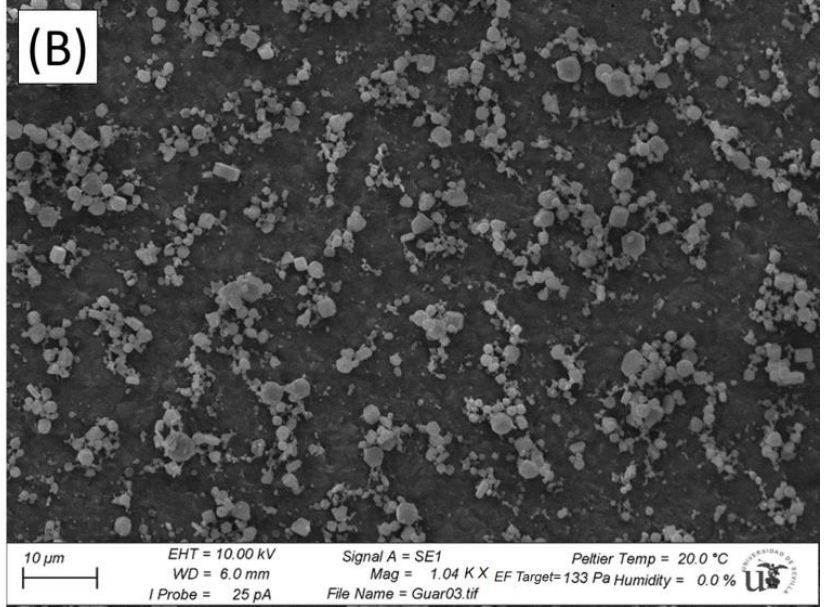
Figure 6. ( A ) Microstructure formed by linseed oil emulsion formulated with 0.3 wt.% of APXG observed by SEM. ( B ) Microstructure formed by linseed oil emulsion formulated with 0.3 wt.% of GG observed by SEM.